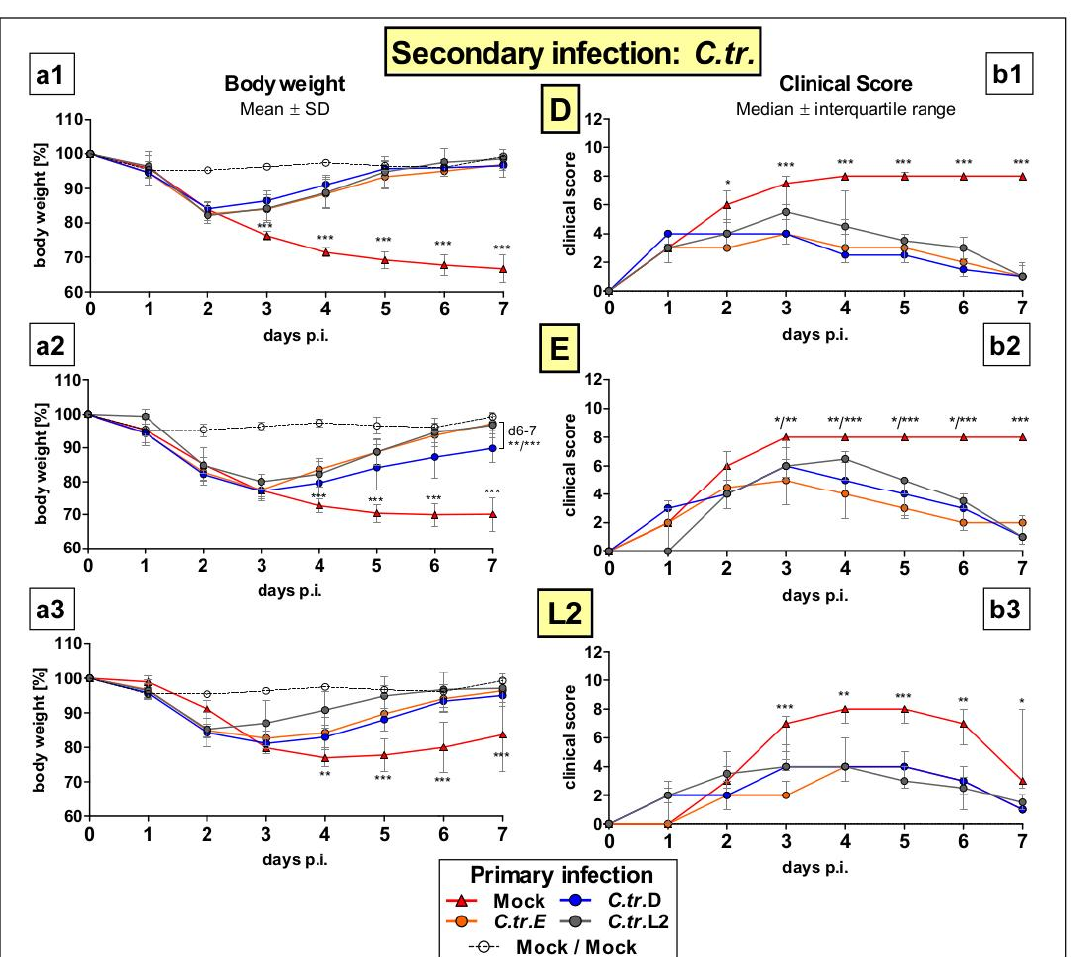
Figure 2. Mice challenged with C.tr. serovars D, E or L2 twice, at the time points of primary and secondary infection, show a similar ameliorated loss of body weight and clinical score, almost independent of the combination of serovars used. Following the mouse lung reinfection protocol, i.n. infected animals receiving C.tr. genital serovars D, E or L2 or mock material, respectively, were infected again with the C.tr. serovars D (upper graphs), E (middle graphs) or L2 (lower graphs) 7 weeks after the primary infection. Mice that were twice infected with mock material served as negative control. Day 0 p.i. in this graph corresponds to day 56 in Figure 1. During the following 7 days, body weight (%; left panels ( a1 – a3 ), mean ± SD) and clinical score (right panels ( b1 – b3 ), median ± interquartile range) were assessed daily. The performed statistical analysis is described in Section 2. Group sizes were n = 8–10 with the exception of n = 6 for C.tr. L2/ C.tr. L2, and n = 4 for Mock/Mock. *–*** indicates statistical significances between the initially mock-infected (red) animal groups and groups previously infected with C.tr. D, E or L2 with p < 0.05, < 0.01, and < 0.001, respectively. Mice that received mock material twice had a clinical score of 0 (data not shown).